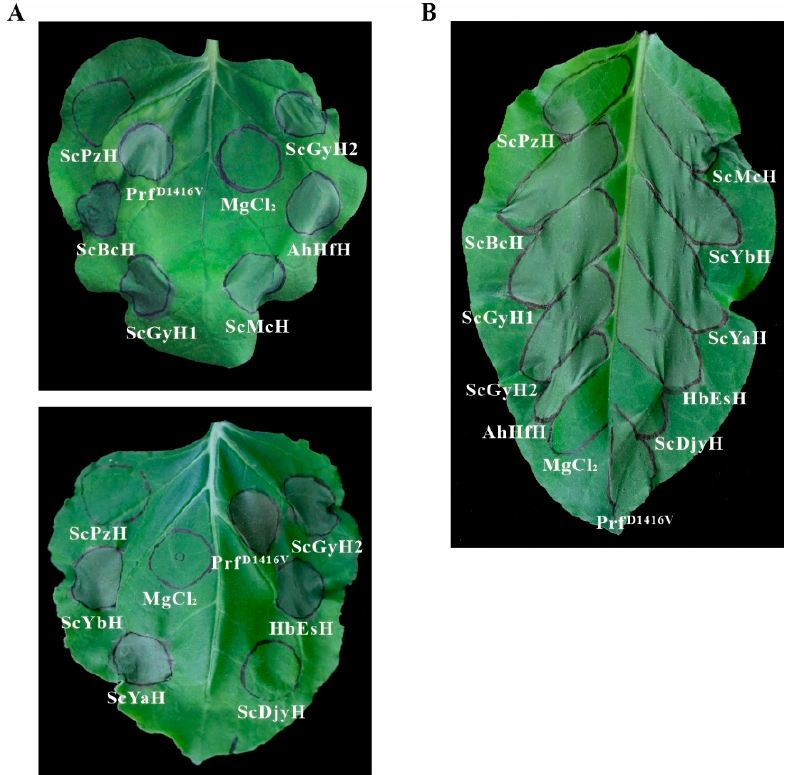
Figure 2. Hypersensitivity response of N . benthamiana ( A ) and N . tabacum ( B ) elicited by the Psa strains. Leaves of 4-to 5-week-old tobacco plants were infiltrated with Psa suspension (10 7 CFU) for 48 h. Prf D1416V and 10 mM MgCl 2 were included as a positive and negative control, respectively.